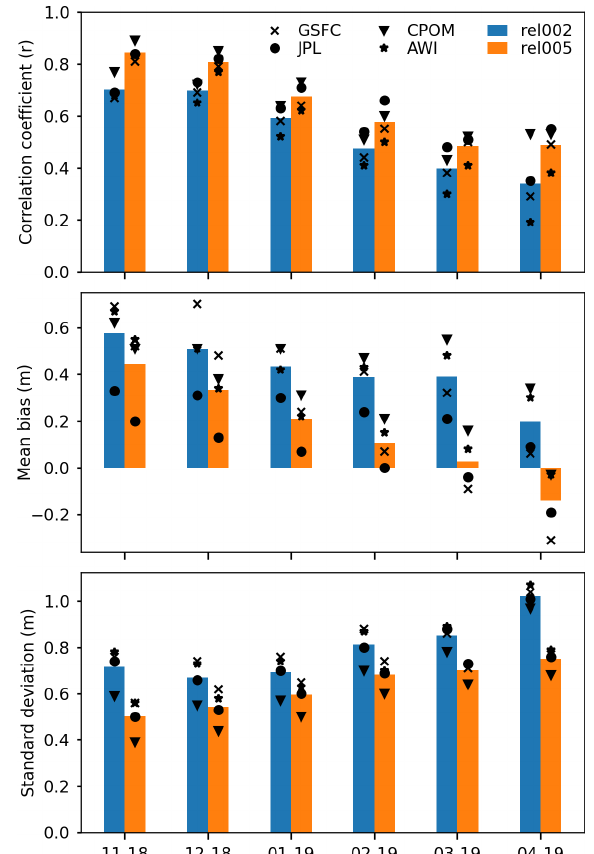
Figure 8. Comparison statistics of monthly gridded CryoSat- 2 thickness for four different CryoSat-2 products (GSFC, JPL, CPOM, AWI) with monthly gridded ICESat-2 sea ice thickness us- ing rel002 (blue) and rel005 (orange) ATL10 and the same snow loading and ice density input assumptions from November 2018 (11–18) to April 2019 (4–19). Data are compared within our Inner Arctic Ocean domain and for grid cells in both datasets that contain thicknesses >